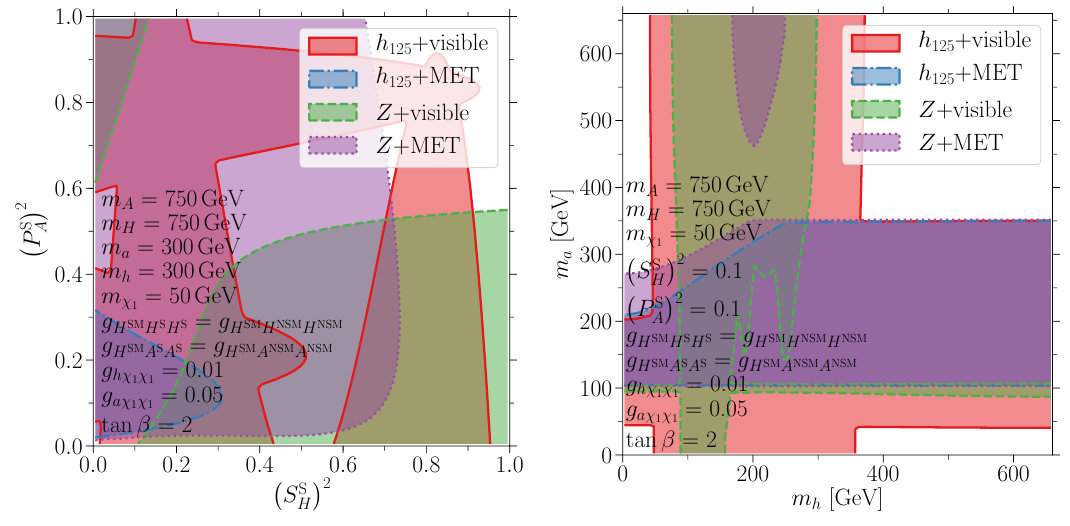
Figure 5 . Regions of 2HDM+S parameter space within the future reach of the di(cid:11)erent Higgs Cascade search modes as indicated in the legend at the LHC with L = 3000 fb (cid:0) 1 of data. The left panel shows the accessible regions in the plane of the singlet fraction of the parent Higgs bosons ( S S ) 2 vs ( P S ) 2 . The right panel shows the reach in the plane of the masses of the daughter Higgs H A bosons produced in the Higgs Cascades, m h vs m a . The remaining parameters are (cid:12)xed to the values indicated in the